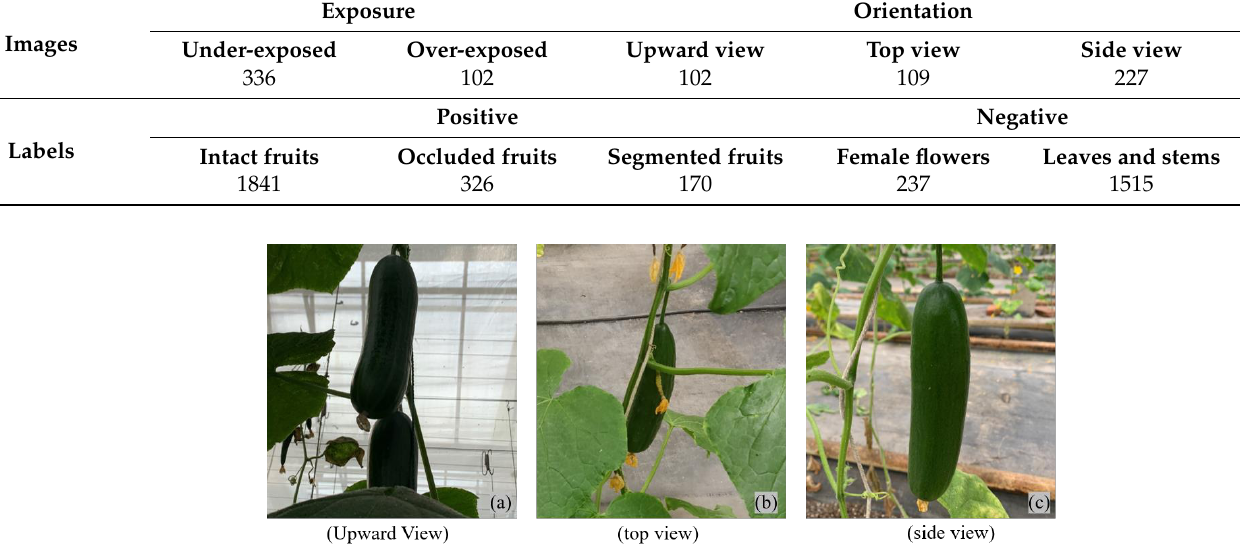
Table 1. Classifications of images ( n = 801) and labels ( n = 3943).